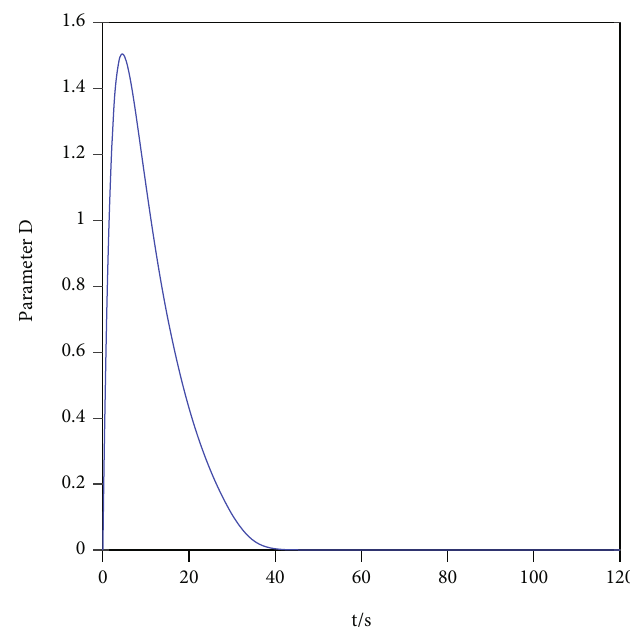
Figure 7: Estimated parameter